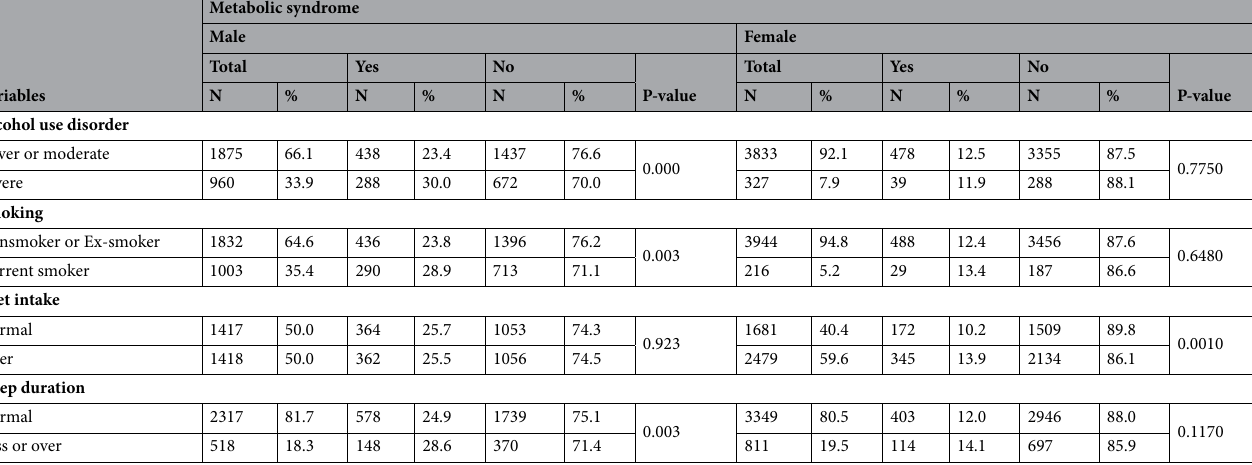
Table 1. General characteristics of the study population. Inoccupation group includes housewife. a Three groups (white, pink, blue) based on International Standard Classification Occupations